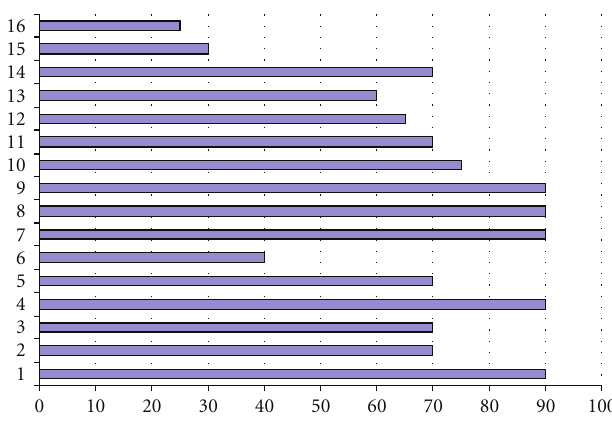
Figure 1: 1 walk around the house, 2 walk up and down stairs, 3 bend over and pick up a slipper from the front of a closet floor, 4 reach for a small can o ff a shelf at eye level, 5 stand on your tip toes and reach for something above your head, 6 stand on a chair and reach for something, 7 sweep the floor, 8 walk outside the house to a car parked in the driveway, 9 get into or out of a car, 10 walk across a parking lot to the mall, 11 walk up and down a ramp, 12 walk in a crowded mall where people rapidly walk past you, 13 are bumped into by people as you walk through the mall, 14 step onto or o ff an escalator while holding onto a railing, 15 step onto or o ff an escalator while holding onto parcels, and 16 walk on icy